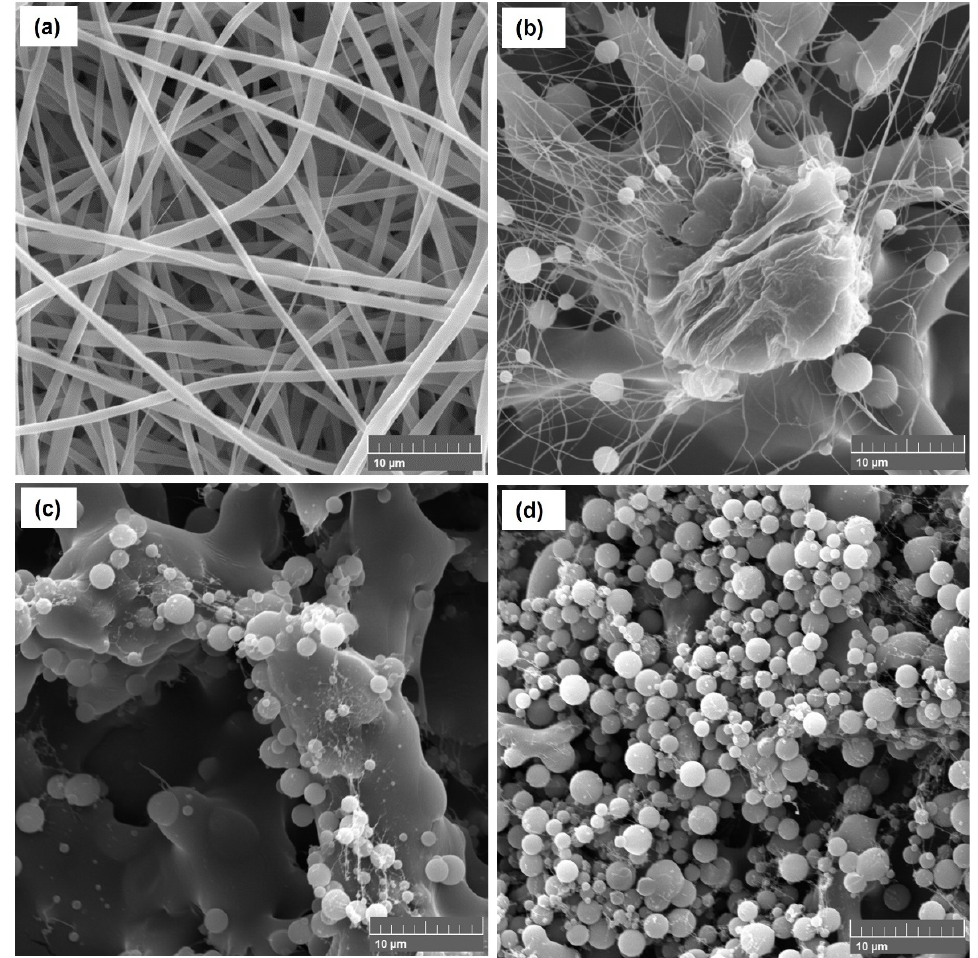
Figure 3. SEM images of the spun A ( a ), sprayed A ( b ), sprayed B ( c ), and sprayed C solutions ( d ). Scale bar = 10 μ m.